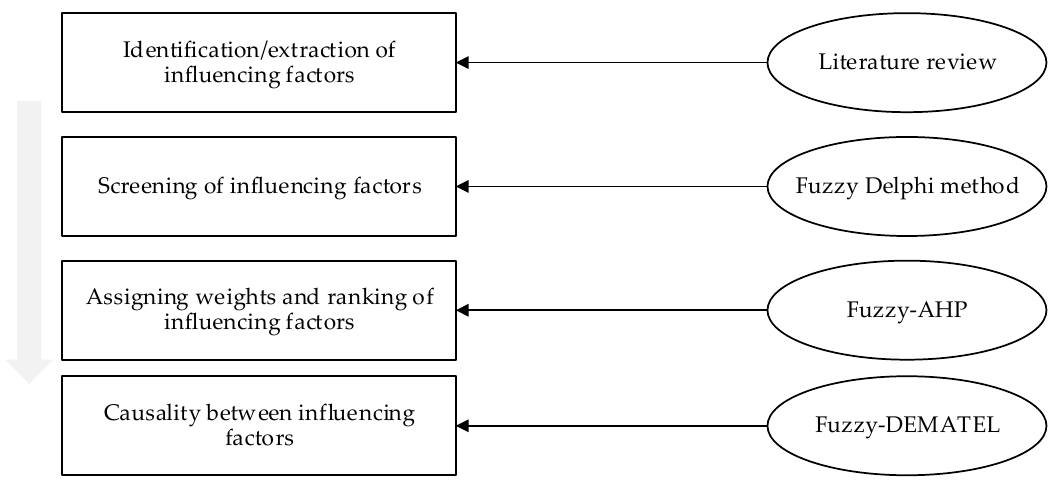
Figure 1. Study scheme of the paper (AHP: Analytic hierarchy process; DEMATEL: Decision Making Trial and Evaluation Laboratory).